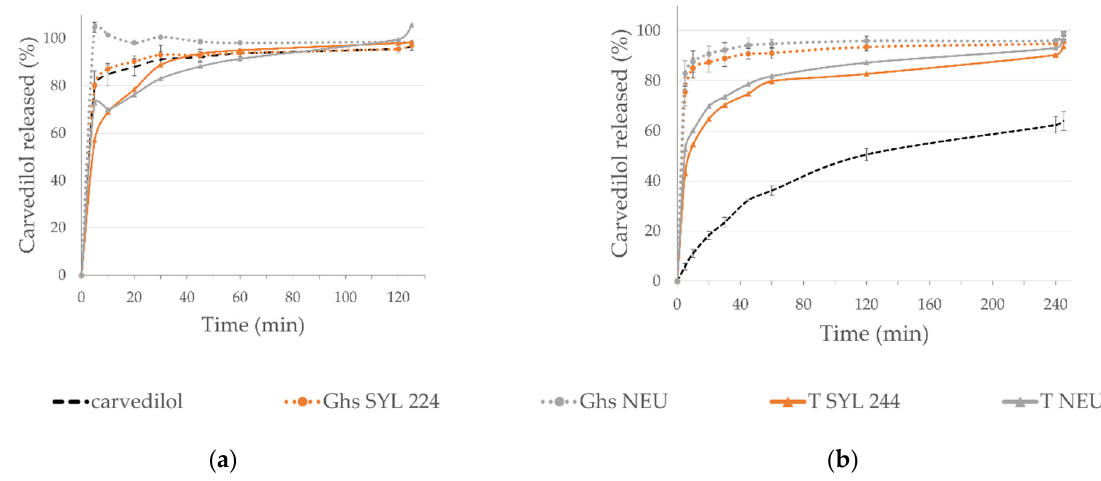
Figure 7. In vitro carvedilol release profiles in dissolution media with pH: ( a ) 1.2; ( b ) 6.8; for SMEDDS granules produced in HS granulator in comparison to corresponding SMEDDS tablets.